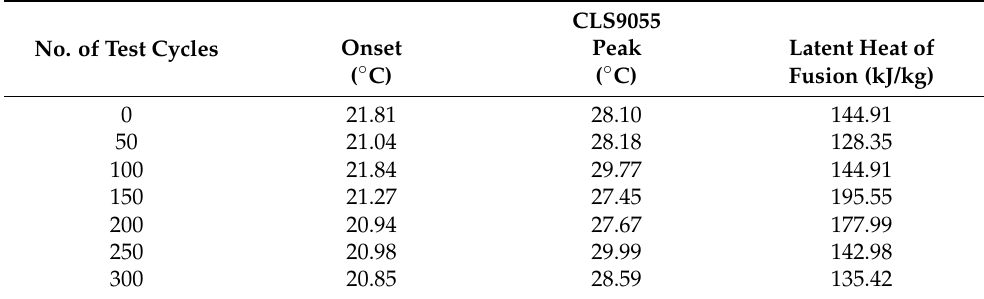
Table 12. Latent heat of fusion and melting temperature of developed materials with test cycles